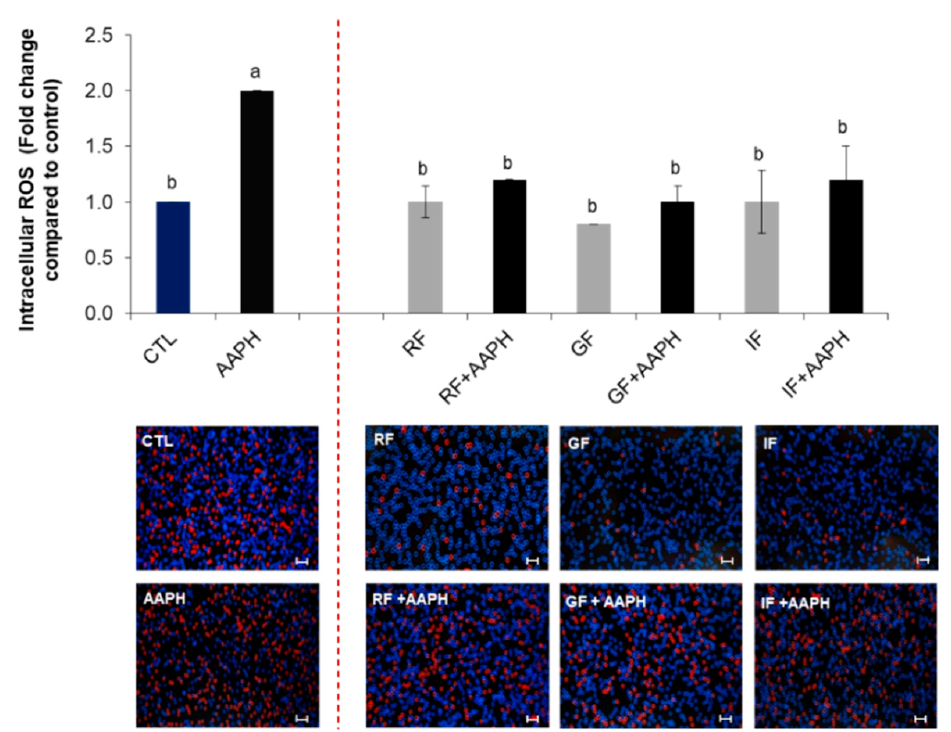
Figure 4. Intracellular reactive oxygen species (ROS) accumulation in HepG2 cells determined by the Tali ® Image-Based Cytometer. Cells were preincubated with the indicated fruit fractions and then stressed with AAPH for 24 h. Values are expressed as the mean ± SD of three independent experiments ( n = 3). Columns belonging to the same set of data with different superscript letters are significantly different ( p < 0.05). Representative images of intracellular ROS quantification are shown following the graphs (stressed cells appear red). Scale bar: 50 µm. CTL: cells without treatment; RF: cells incubated with the raw fruit; GF: cells incubated with fruit after gastric digestion; IF: cells incubated with fruit after intestinal digestion; AAPH: cells incubated with AAPH; RF + AAPH: cells preincubated with the raw fruit and then stressed with AAPH; GF + AAPH: cells preincubated with fruit after gastric digestion and then stressed with AAPH; IF + AAPH: cells preincubated with fruit after intestinal digestion and then stressed with AAPH.